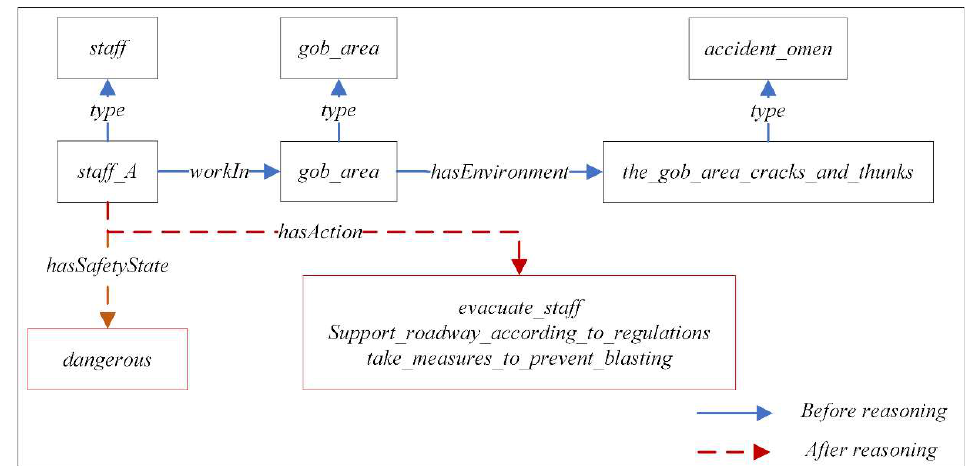
Figure 11. Semantic rule-based inference chain for accident omen.